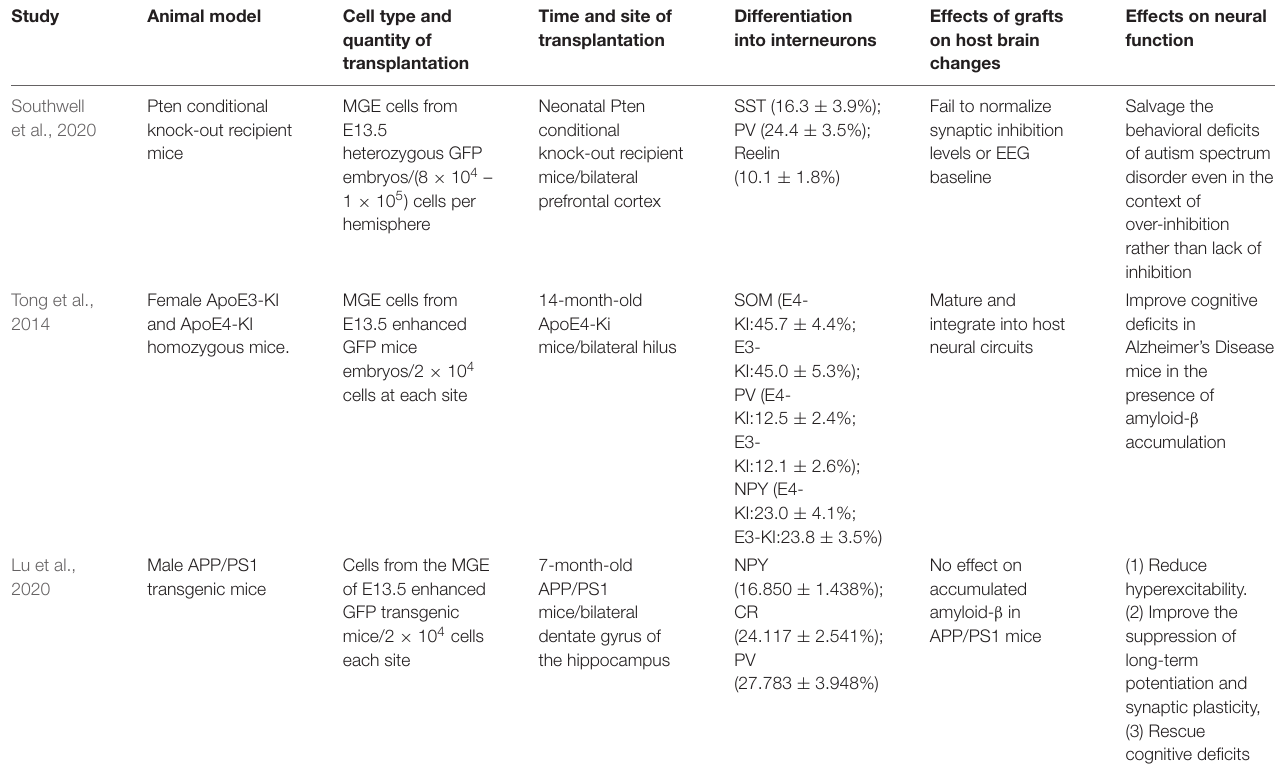
TABLE 3 | Medial ganglionic eminence cell transplantation for autism spectrum disorder and Alzheimer’s